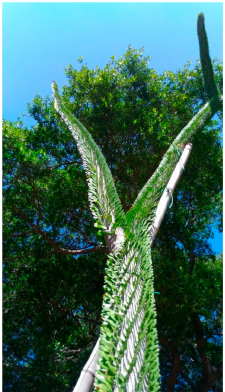
Figure 1. Alluaudia procera growing at the Botanical Garden of the University of